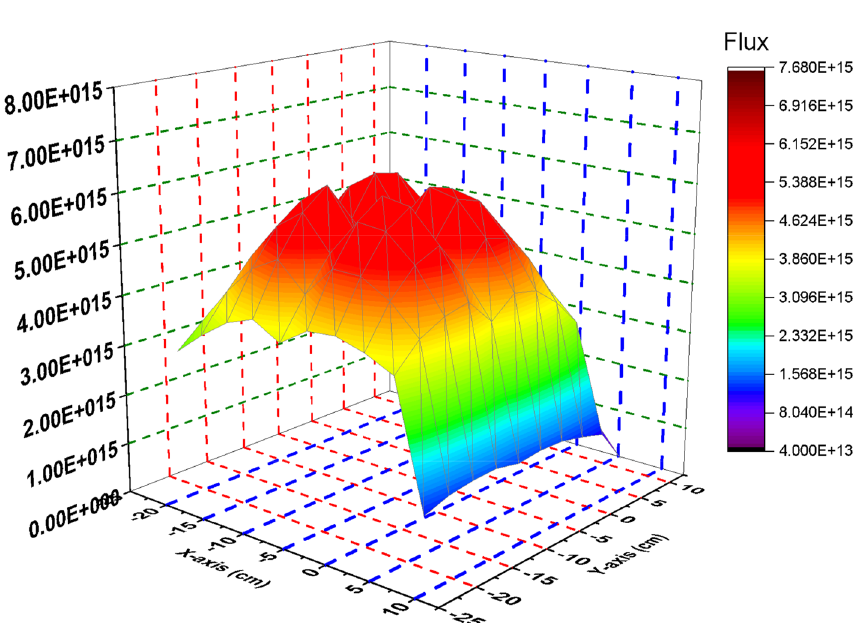
Figure 6. Fast Flux distribution for the four bundle using 10 meshes in case of B4C in the control